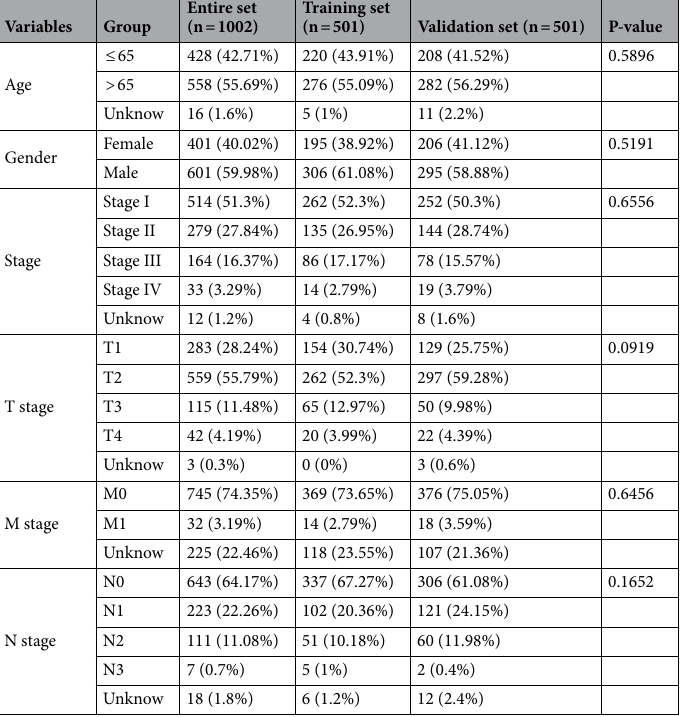
Table 1. Clinical information of the entire set, training set and validation set. TCGA The Cancer Genome